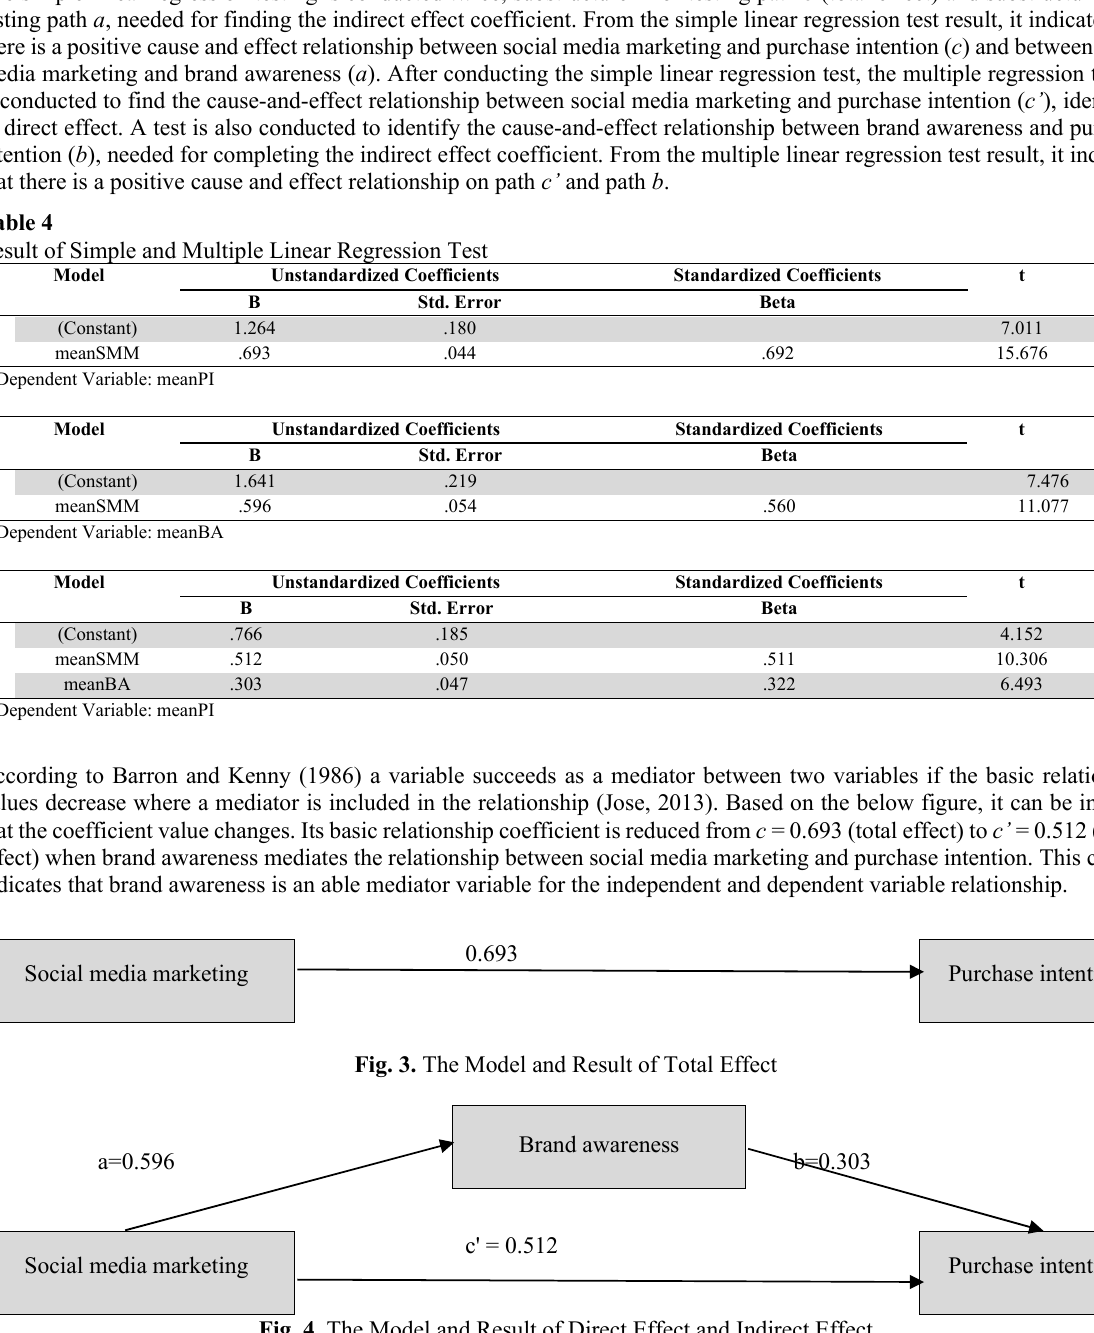
Fig. 4. The Model and Result of Direct Effect and Indirect